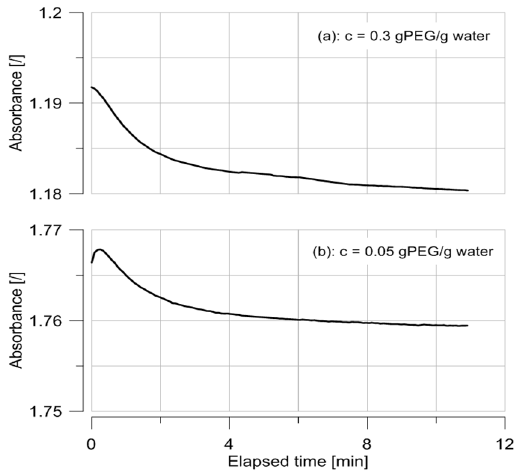
Figure 3. Evolution of absorbance with time of solutions of PEG 20,000 at 0.05 ( a ), and 0.3 g PEG/g water ( b ).